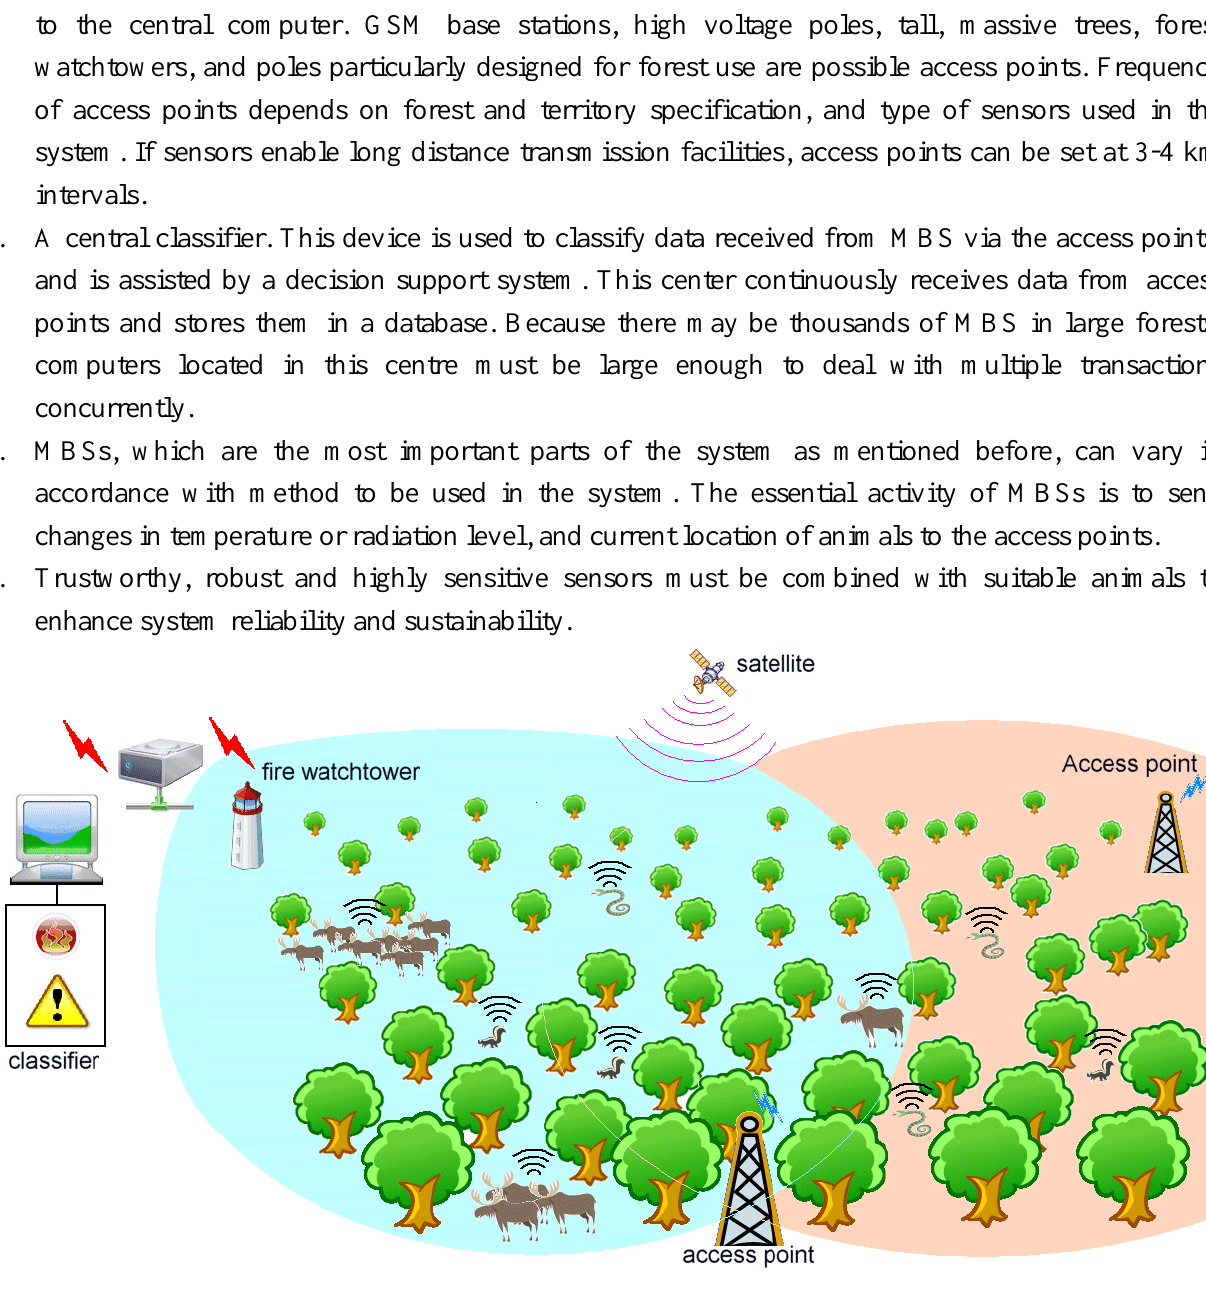
Figure 4. Forest fire detection system’s